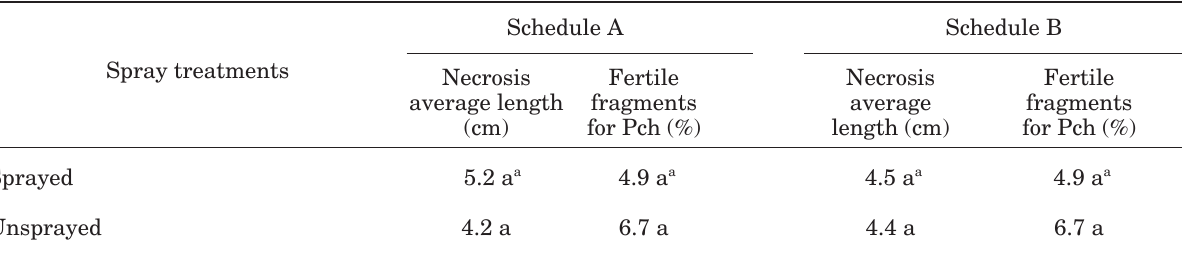
Table 4. Effect of copper formulation sprays on the length of necrosis caused by Phaeomoniella chlamydo- spora (Pch) and on extent of colonization 3 years after inoculation in the trunk of potted